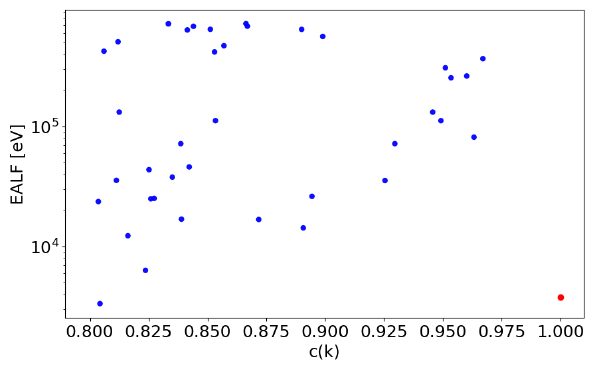
Figure 4a. EALF for the relevant experiments and Case